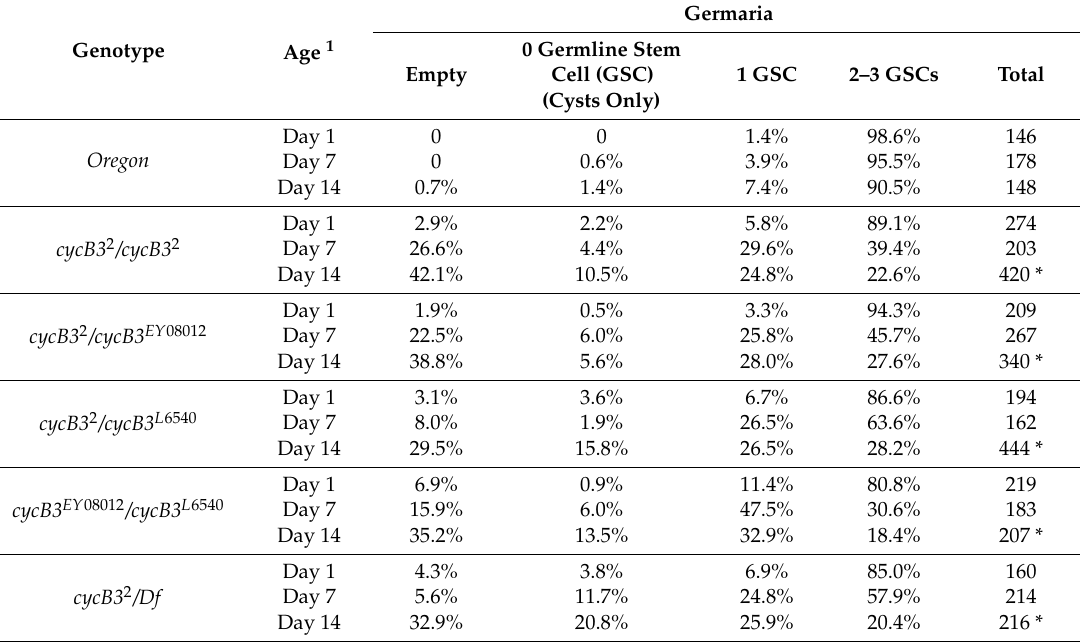
Table 1. Phenotypic assay for cycB3 mutation in Drosophila